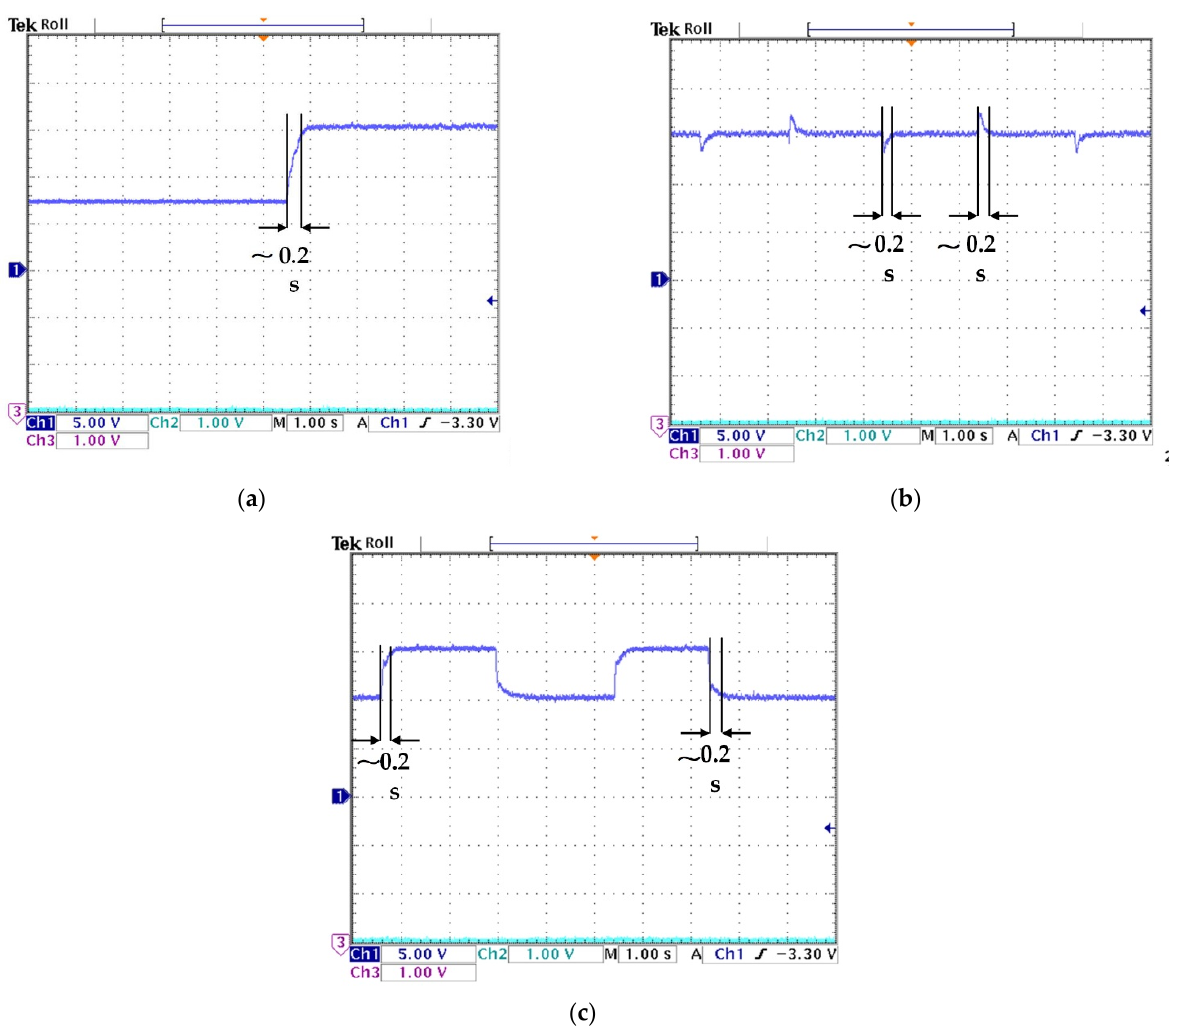
Figure 15. Oscilloscope output results: ( a ) Transient output response of the boost converter for the reference voltage of 15 V, ( b ) output response waveform of input voltage changes from 8 V to 10 V (and vice-versa), and ( c ) the output voltage changes with the presence of a change in voltage reference from 15 V to 10 V (and vice-versa) implementation.